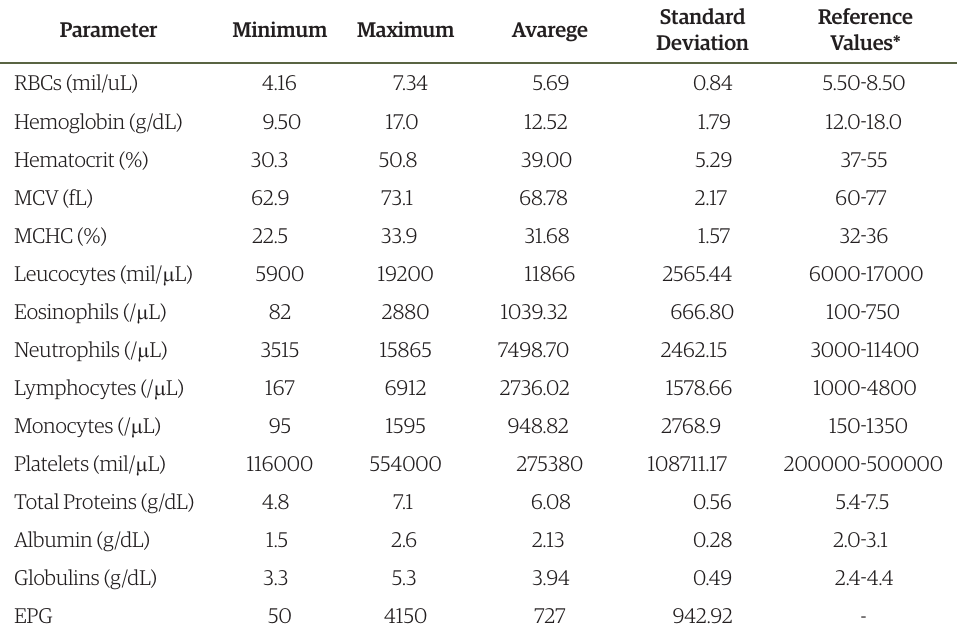
*Merck Veterinary Manual (Amstutz,